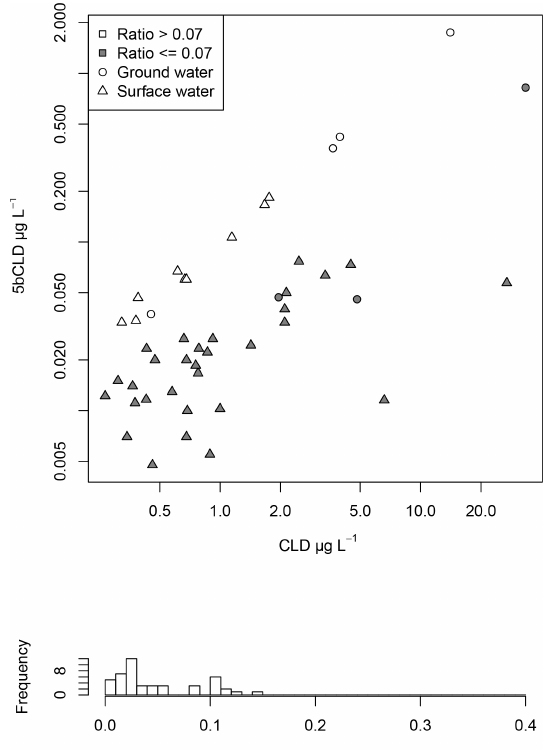
Figure 2. Relation between CLD and 5bCLD means at each sam- pling point for surface water and groundwater; distributions of the mean of the 5bCLD / CLD ratio are given below the 2-D